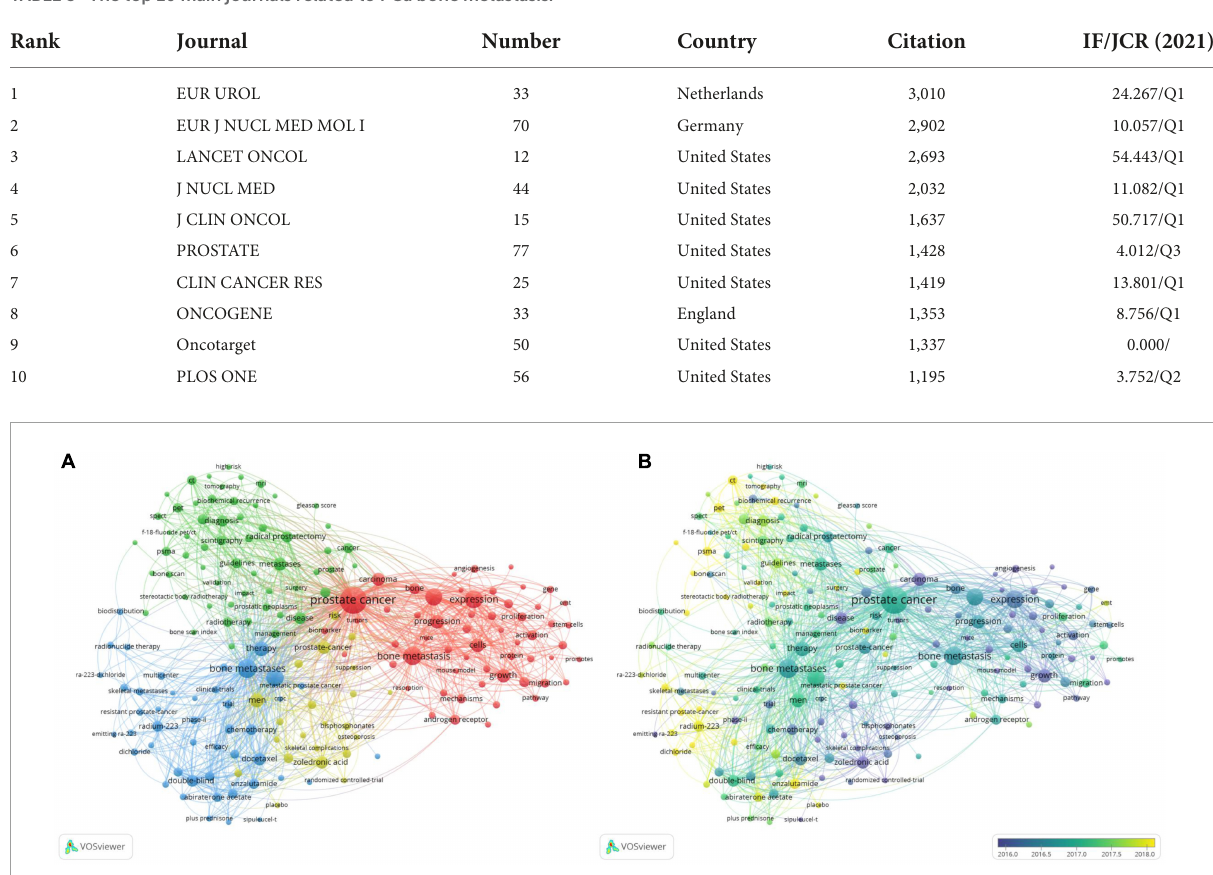
TABLE 5 The top 10 main journals related to PCa bone metastasis.